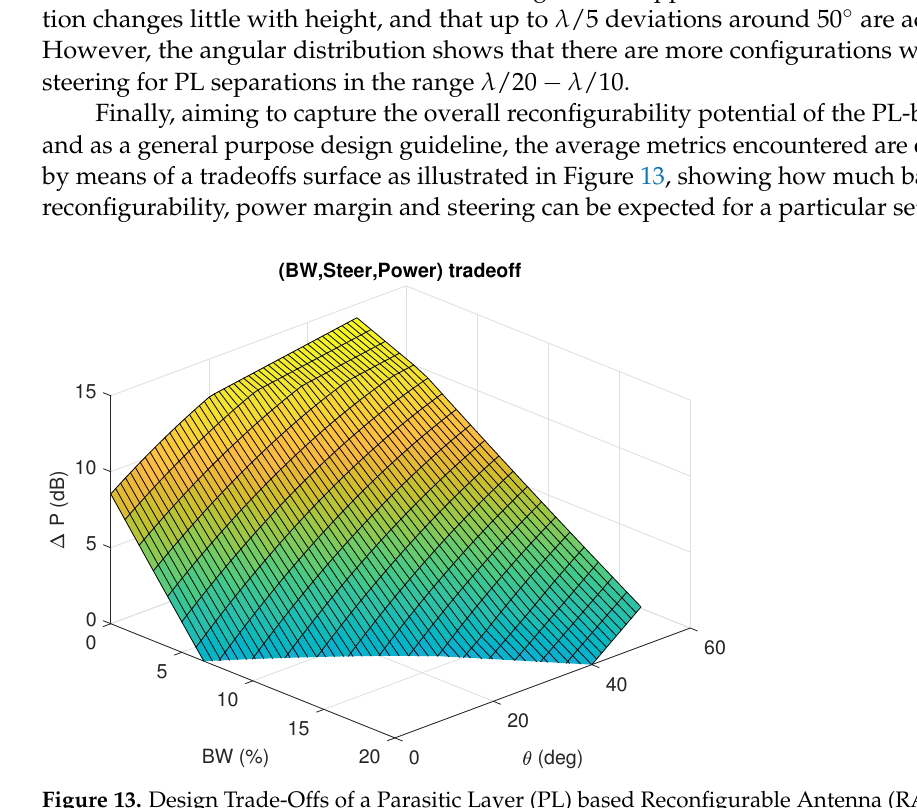
Figure 13. Design Trade-Offs of a Parasitic Layer (PL) based Reconfigurable Antenna